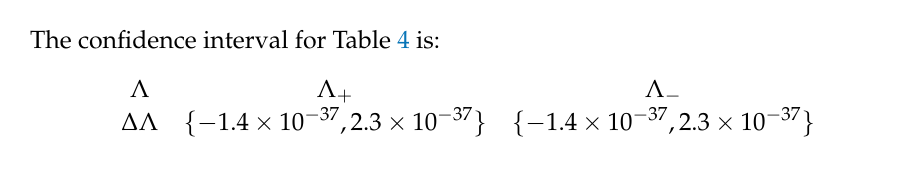
Table 4. Estimation of the cosmological constant using the first